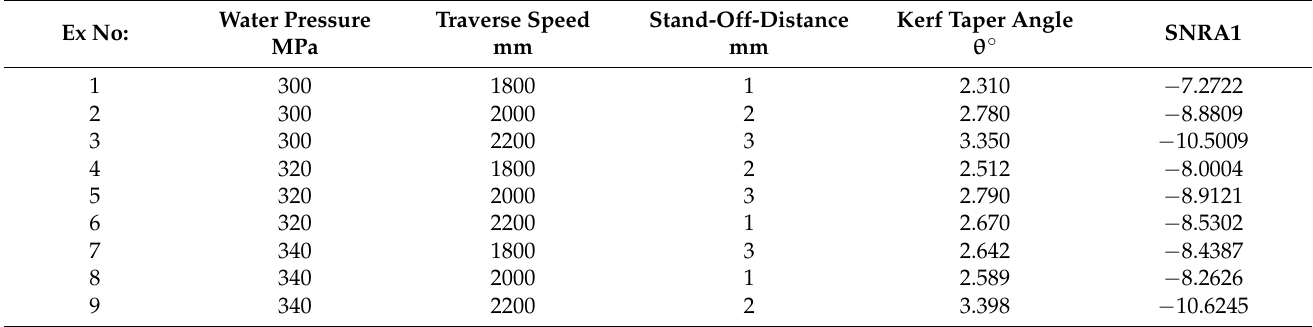
Table 19. L9 array of input parameter levels with measured Kerf taper angle θ ◦ in degrees and calculated signal-to-noise (S/N) ratio based on the Taguchi method for 4 mm specimen thickness cut with abrasive water jet technique. Ex No: